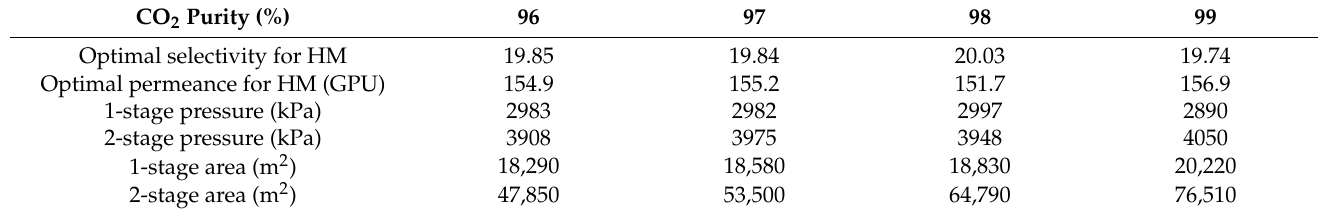
Table 5. Information of the optimal process of increasing CO 2 purity when the H 2 -selective membrane changes based on the Robeson upper bound.